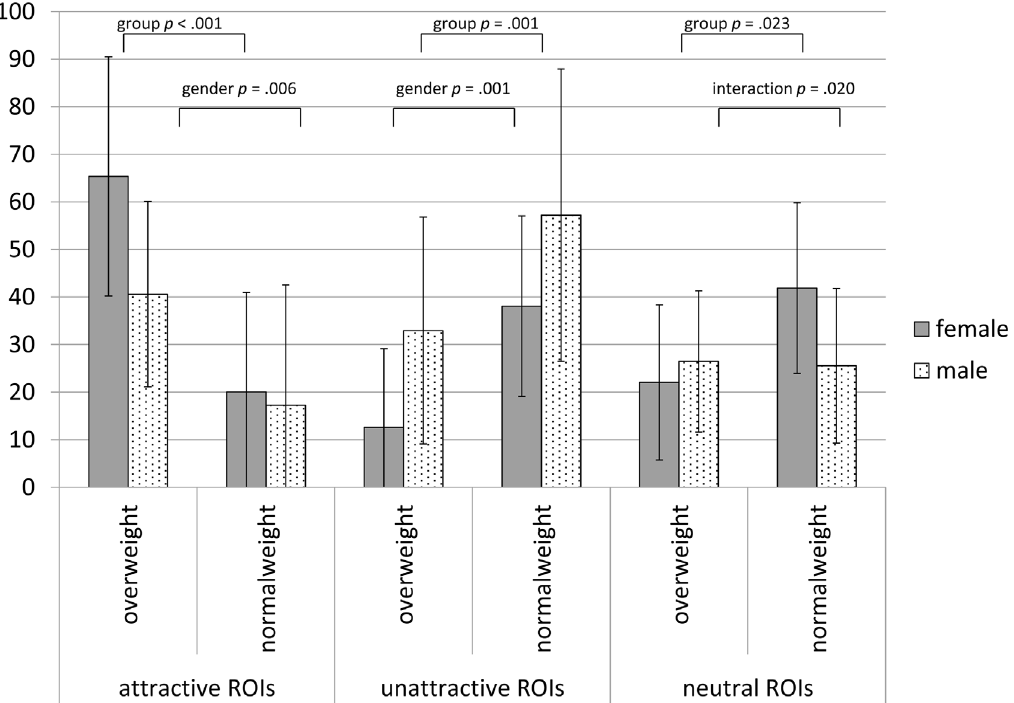
Fig 2. Percentage of dwell time for one ’ s own body (mean, standard deviation) for attractive, unattractive and neutral ROIs. Displayed are p -values of between-subjects analysis, following significant multivariate analysis (group F (2, 50) = 12.96; p < .001, η 2 = .341; gender F (2, 50) = 5.77, p = .006, η 2 = .187; interaction F (2, 50) = 3.11, p = .053, η 2 = .111; covariate age F (2, 50) = 0.66, p = .422, η 2 =